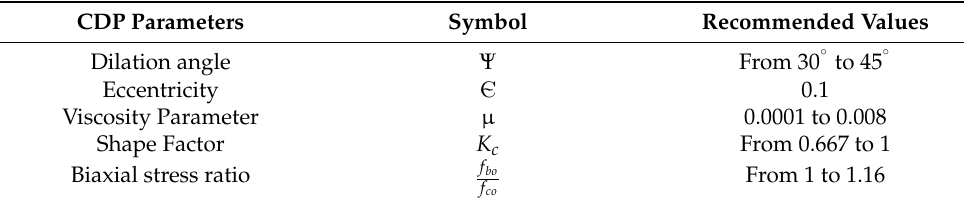
Table 1. Recommended values for CDP model